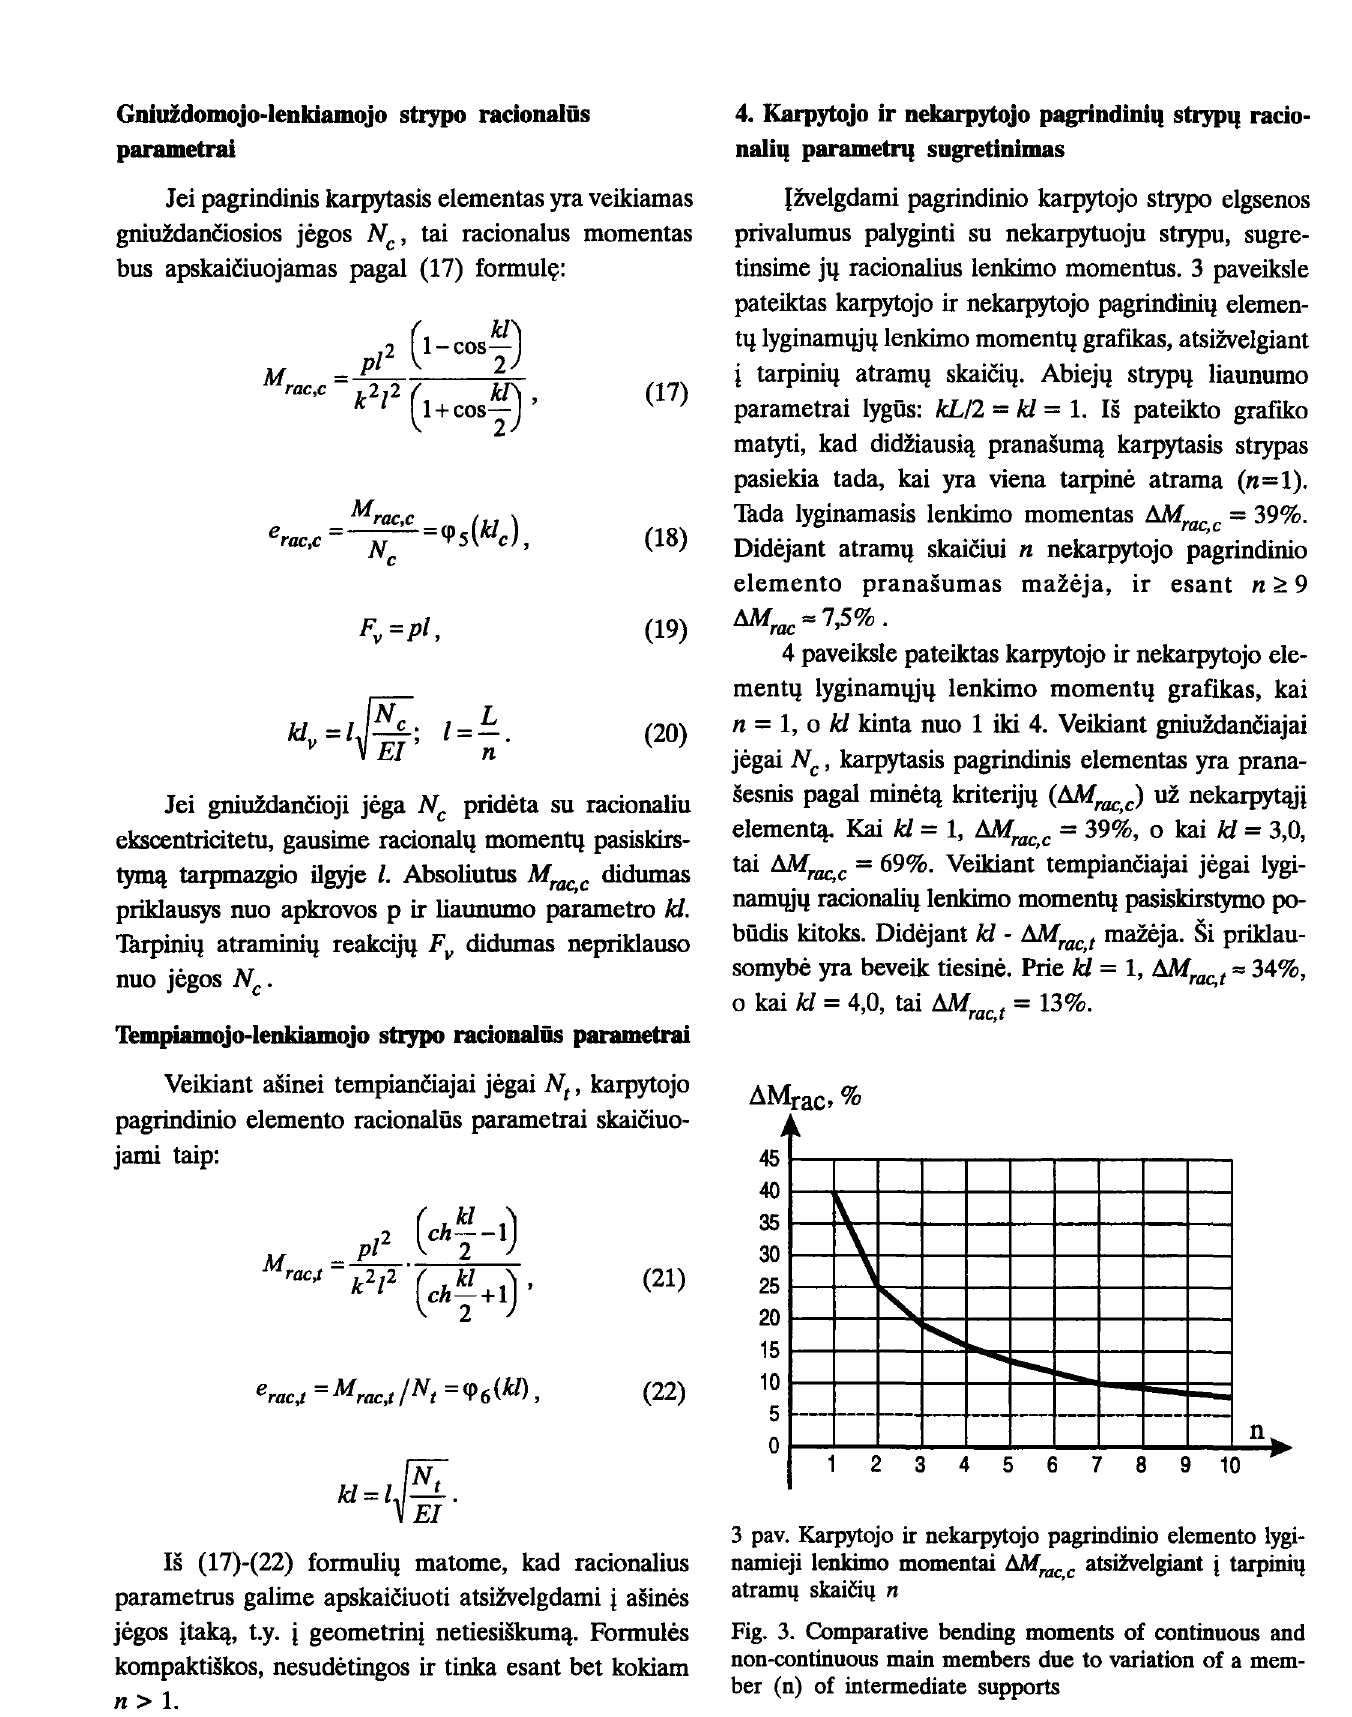
Fig. 3. Comparative bending moments of continuous and non-continuous main members due to variation of a mem ber (n) of intermediate